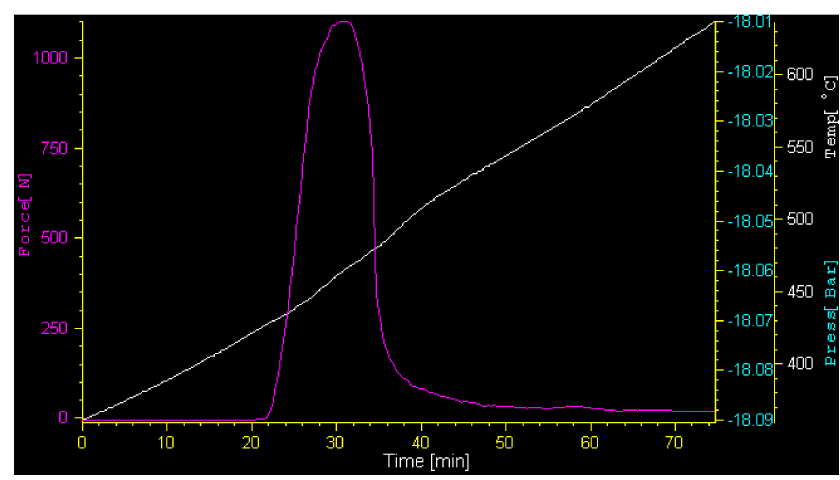
Figure 3. Sample visualization of the course of pressure measurement.